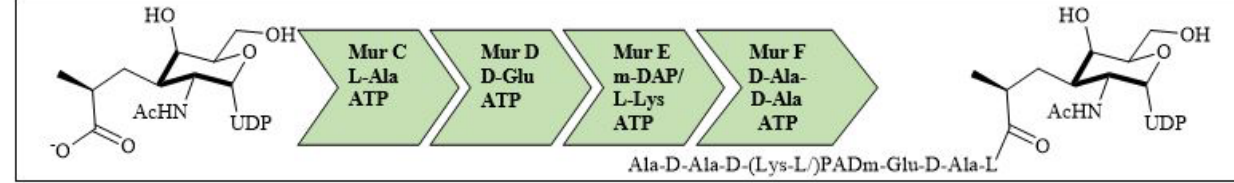
Figure 7. Peptidoglycan peptide stem formation by the Mur ligases enzymes.